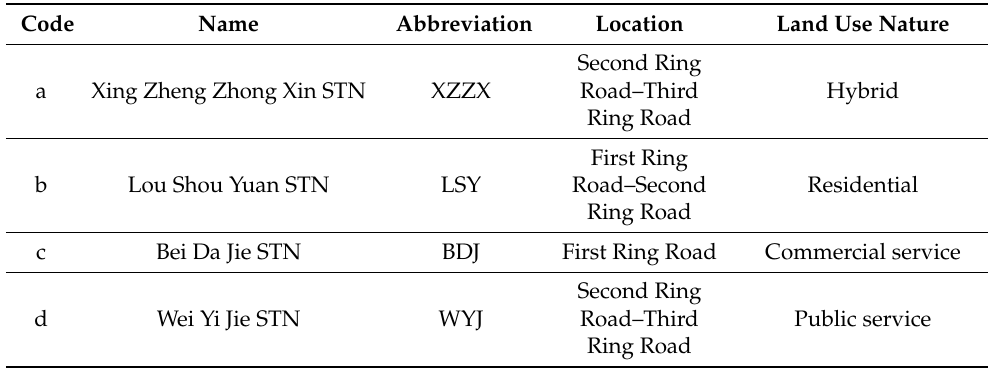
Table 2. Classification results of four station